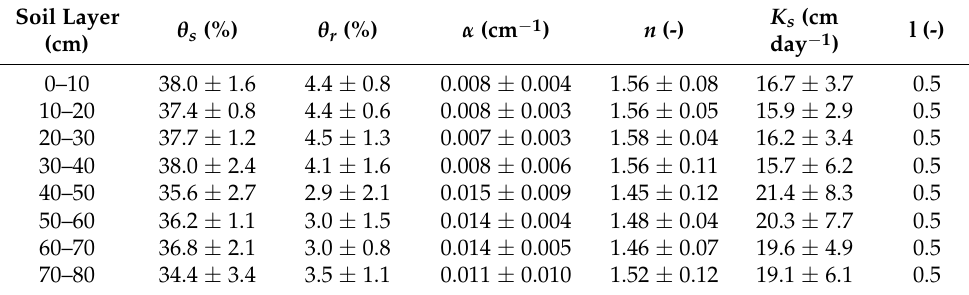
Table 4. Optimized hydraulic parameters in the